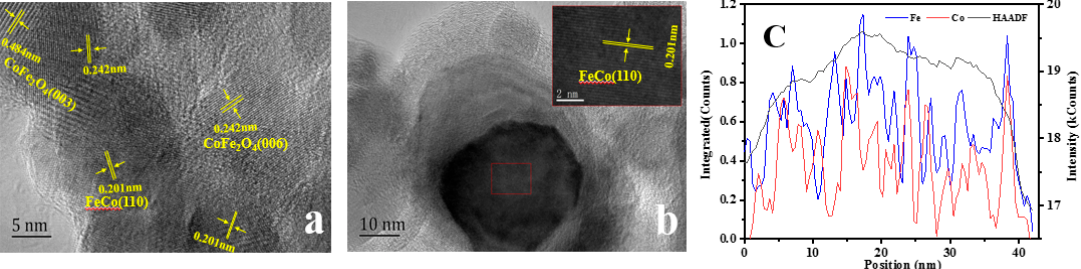
Figure 5. HR-TEM images of ( a ) FeCo/NC-400; ( b ) FeCo/NC-600; and ( c ) EDX spectra of FeCo/NC-600.